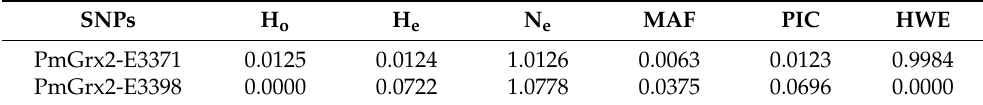
Figure 7. Sequencing maps of the SNPs of PmGrx2 . Table 1. Specific information of the SNPs of PmGrx2 . Table 2. Polymorphic parameters of the SNPs of PmGrx2 .